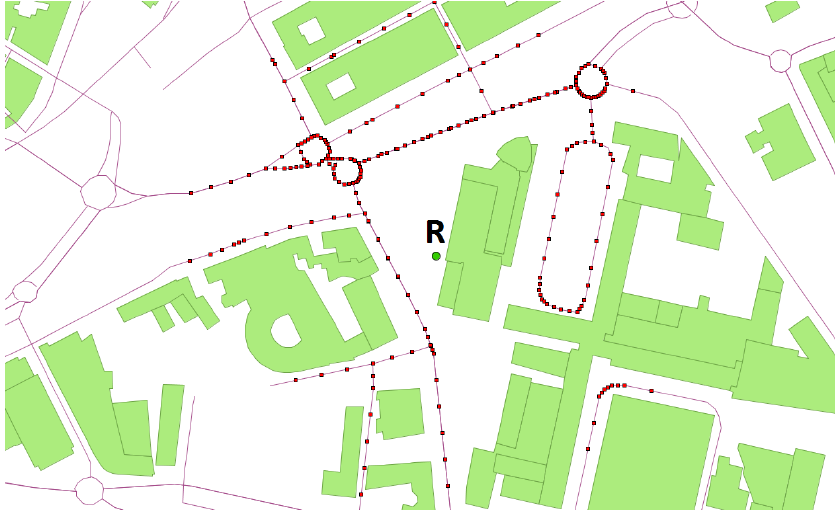
Figure 4. Search of the “active” sound sources (red) for a given receiver point R (green). An “active” sound source may be located in adjacent subdomains.